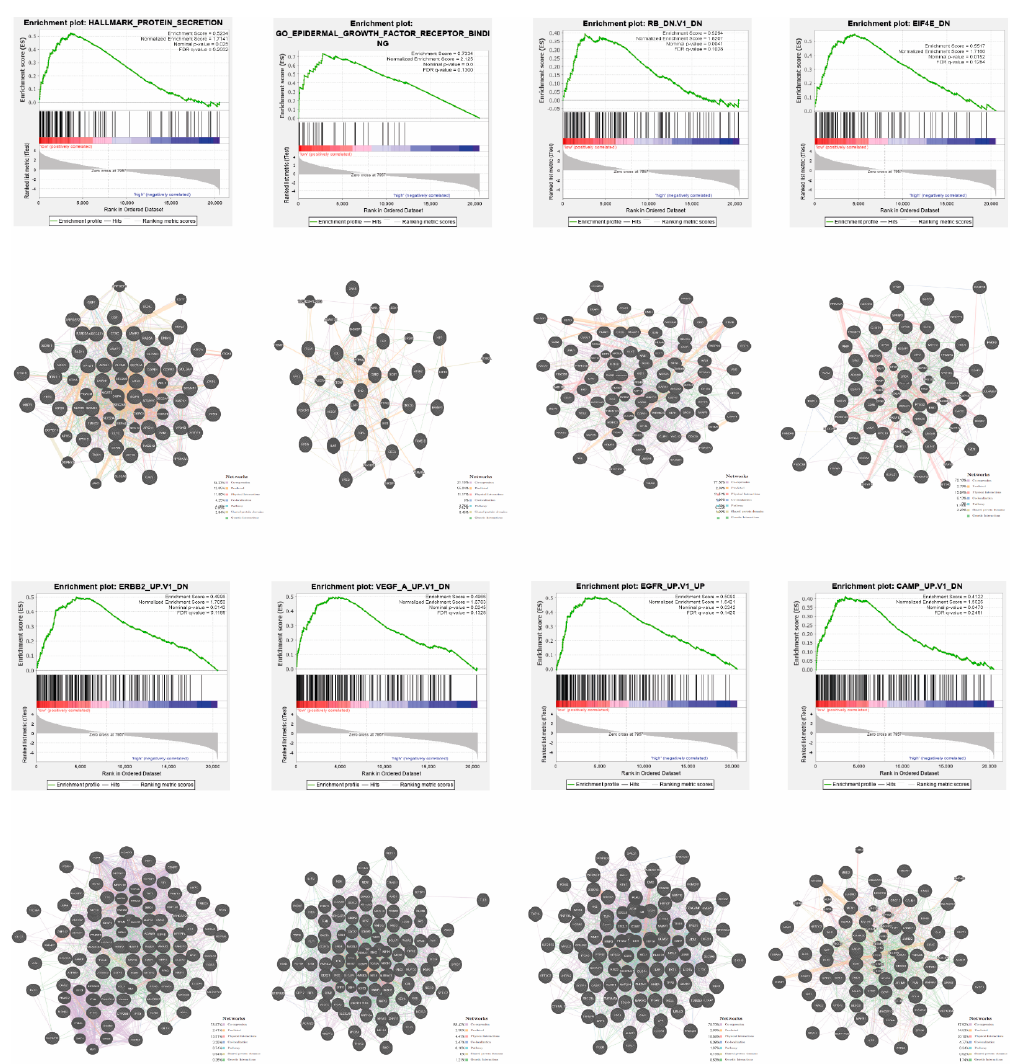
Figure 8. Gene set enrichment analysis (GSEA) and GeneMania analysis.